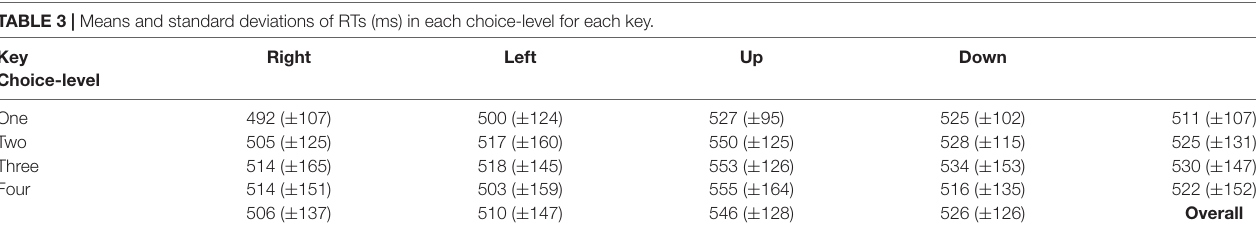
TABLE 3 | Means and standard deviations of RTs (ms) in each choice-level for each